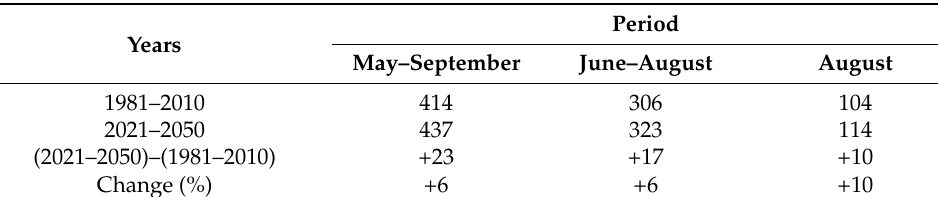
Table 4. Comparison of the water needs of grapevines (mm) in the reference years (1981–2010) and in